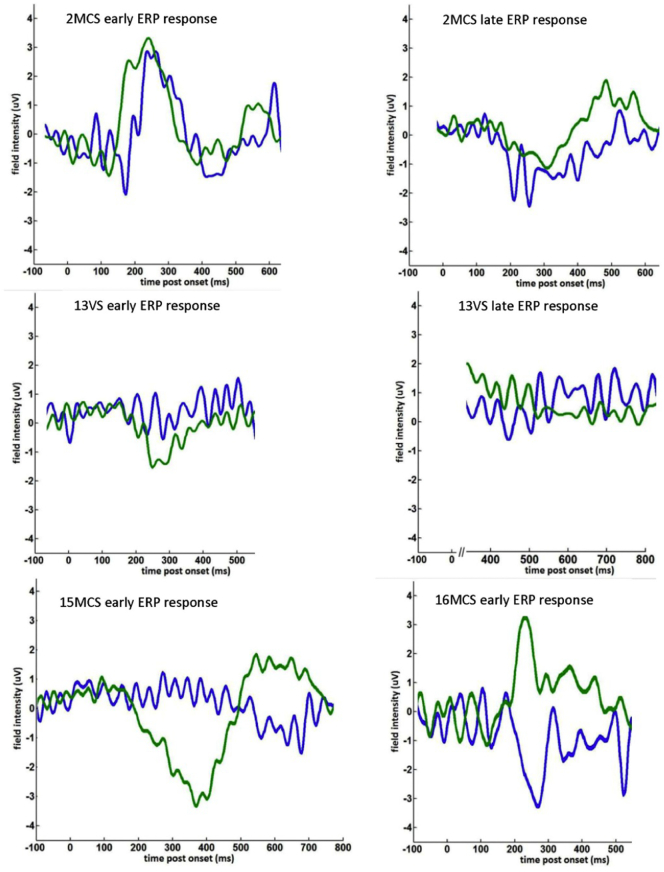
Represents the Event Related Response to own name (blue line) and other names (green line) in individual patients.